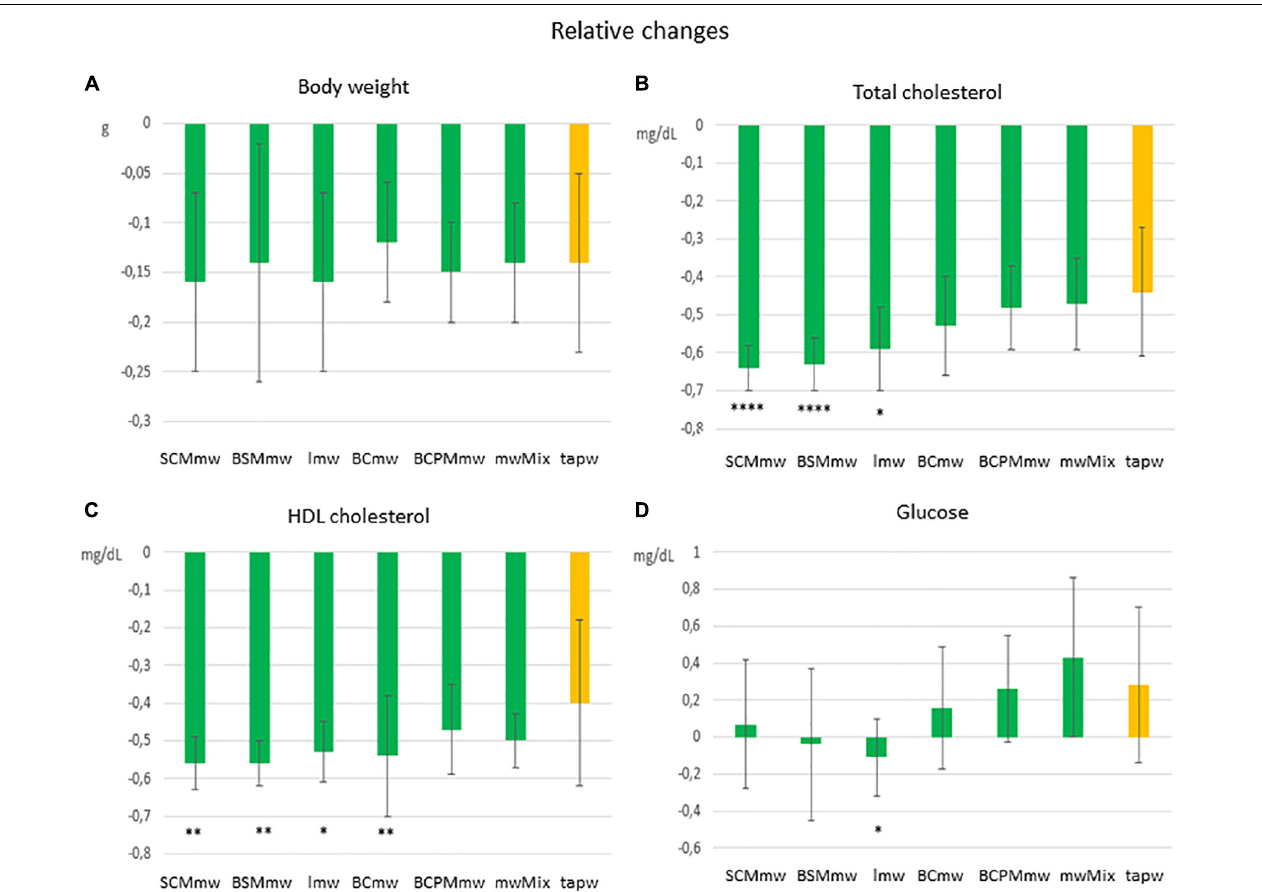
FIGURE 4 | Main effect of treatment on relative changes in physical and biochemical parameters among treated mice. The figure shows average relative differences (T6–T4/T4 ± SDs; A–D ) in physical and biochemical parameters in different mineral water-treated mice and tap water-treated control group. Each group includes both males and females. The groups are: SCMmw, sulphate-, calcium-, and magnesium-rich mineral water; BSMmw, bicarbonate-, sulphate-, and magnesium-rich mineral water; lmw, light mineral water; BCmw, bicarbonate- and calcium-rich mineral water; BCPMmw, bicarbonate-, calcium-, potassium-, and magnesium-rich mineral water; mwMix, alternation of NMWs; tapw, low mineral content tap water. Between-group analysis for the effect of treatment was performed by one-way ANOVA, followed by Dunnett’s test, comparing each group against the control group. * P ≤ 0.05, ** P ≤ 0.01, and **** P ≤